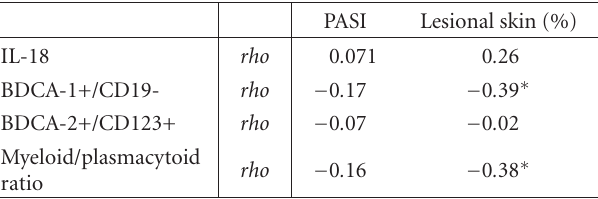
Table 3: Spearman rho correlation coe ffi cients between IL-18, DCs, and clinical characteristics of psoriasis in patients with psoria- sis. Correlations marked by asterisk are statistically significant with P < .